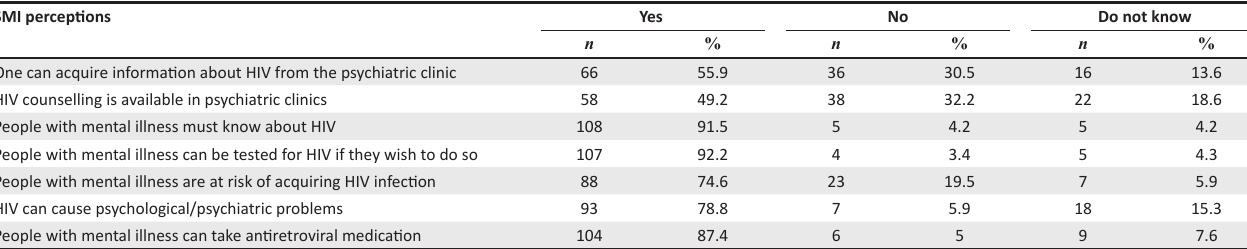
TABLE 3: Perception of patients with severe mental illness on HIV services at psychiatric clinics. SMI perceptions